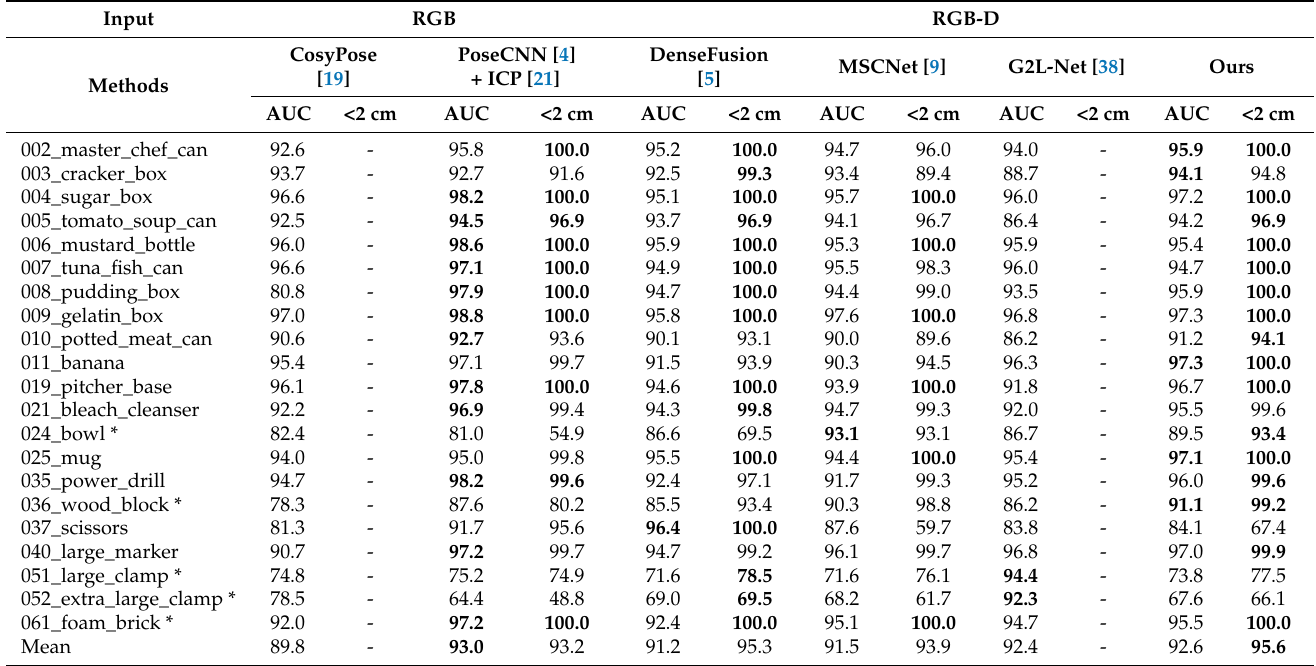
Table 2. Quantitative evaluation results using the ADD-S metric on the YCB-Video Dataset, where the data shown in bold are the highest scores among the different methods, and the objects marked with an asterisk * are symmetrical